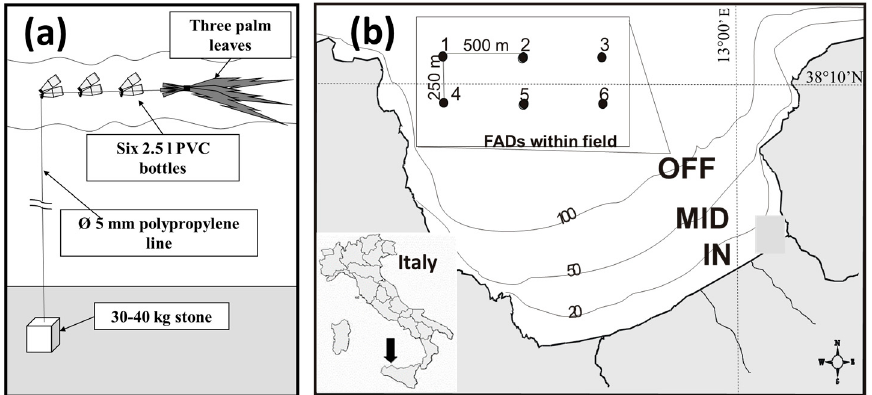
Figure 1. ( a ) Scheme of FAD setup used in this study; ( b ) Study Area. OFF (offshore), MID (mid-shore) and IN (inshore) indicate the three FAD